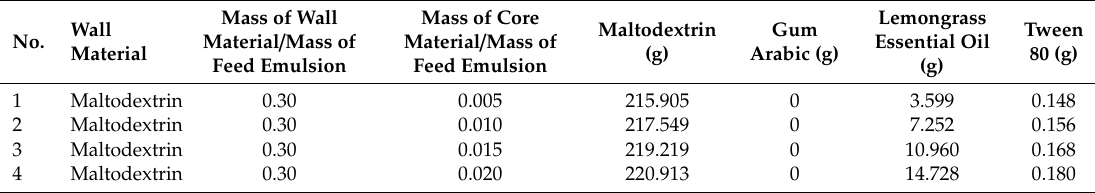
Table 2. Feed emulsion compositions in the second